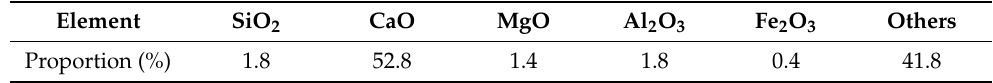
Table 3. Chemical composition of limestone.